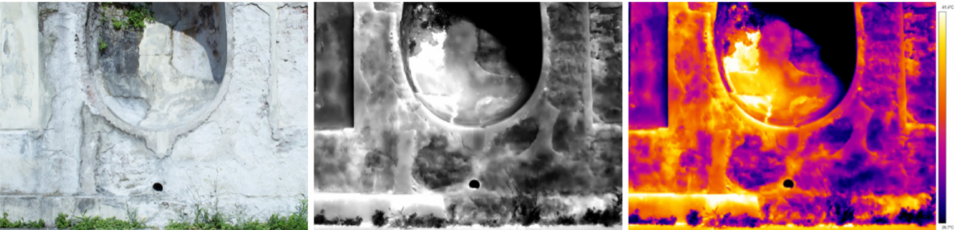
Figure 4. Color image and corresponding thermographic image (grey and iron color pallet) captured at Turin’s Castello del Valentino (Italy) riverside façade.